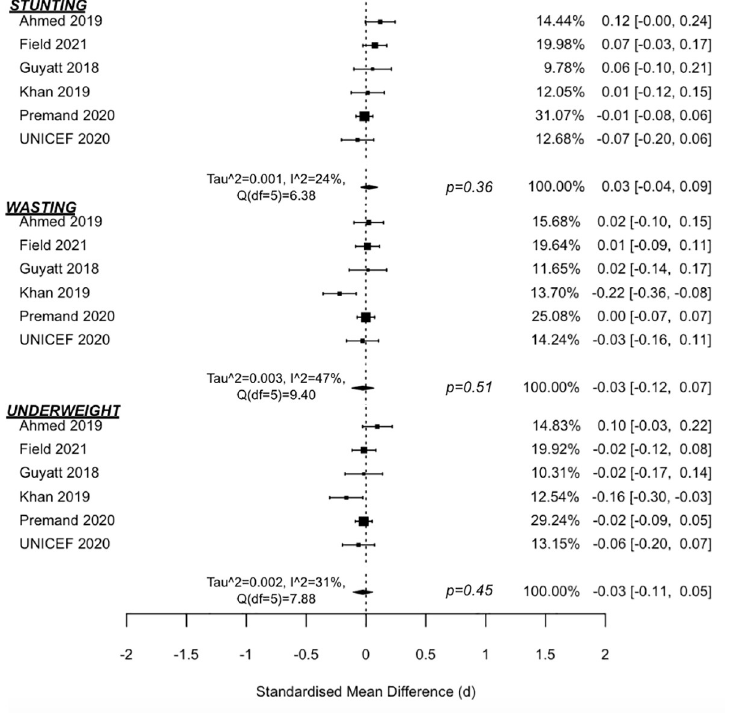
Fig 3. Forest plot of Cash + Nutrition BCC vs. cash alone on anthropometric z-scores.